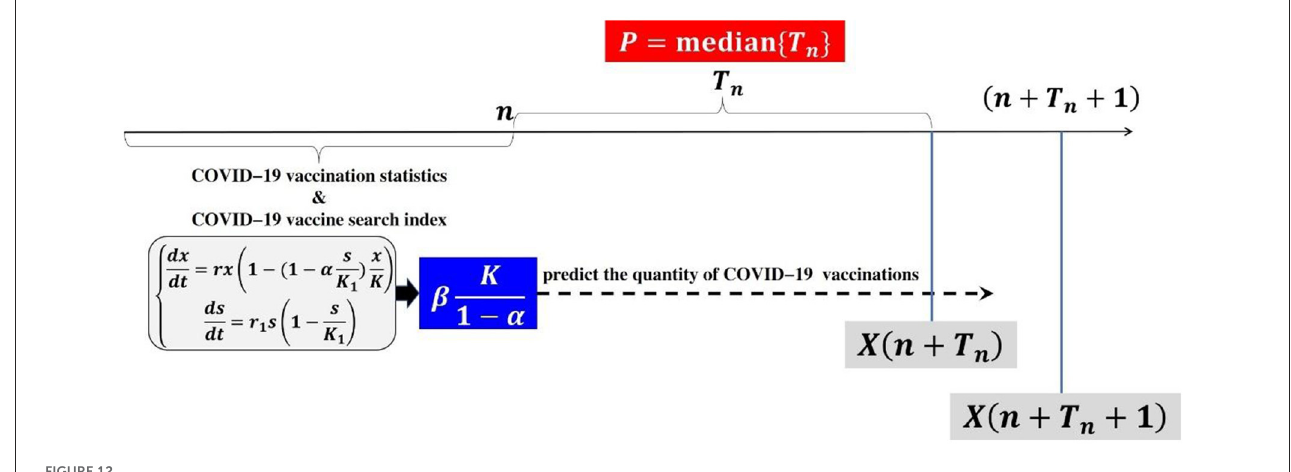
FIGURE12 Prediction